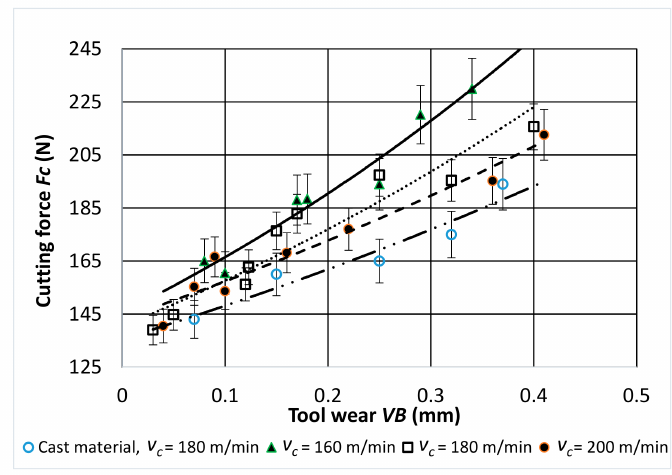
Figure 9. Characteristic of the Fc component of the total cutting force as a function of cutting edge wear VB for: f = 0.048 mm/rev; a p = 0.5 mm.